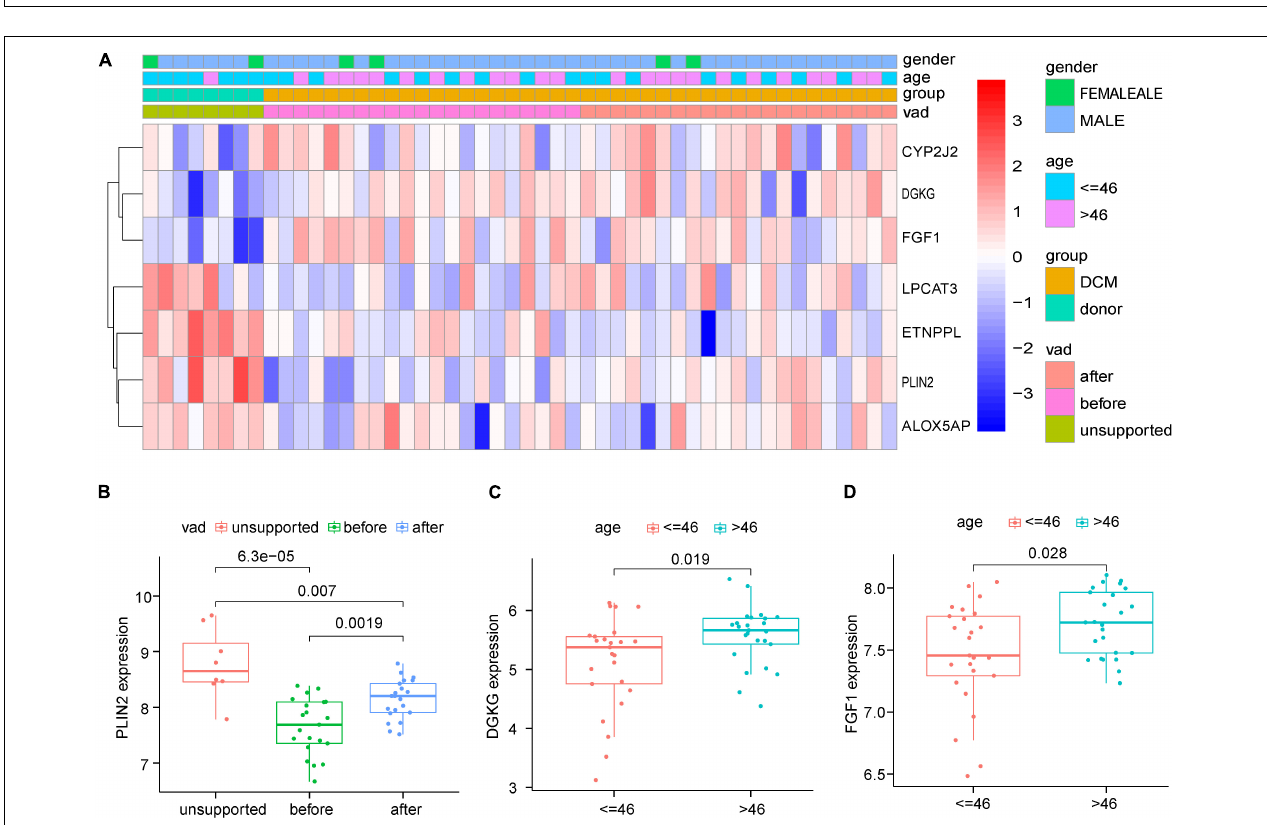
FIGURE 4 | Identify 7 differentially expressed lipid metabolism-related genes. (A) Venn diagram of differentially expressed lipid metabolism-related genes based on validation sets (EGAS00001003263) and the integrated microarray dataset. (B) RT-qPCR analysis for mRNA levels of the in the mRNA expression of the 7 DELs in dilated hearts (red bars) vs. Donor hearts (blue bars). The values from the Donors were set to 1. Data are presented as mean ± SEM. * P < 0.05, ** P < 0.01 vs. Donors.